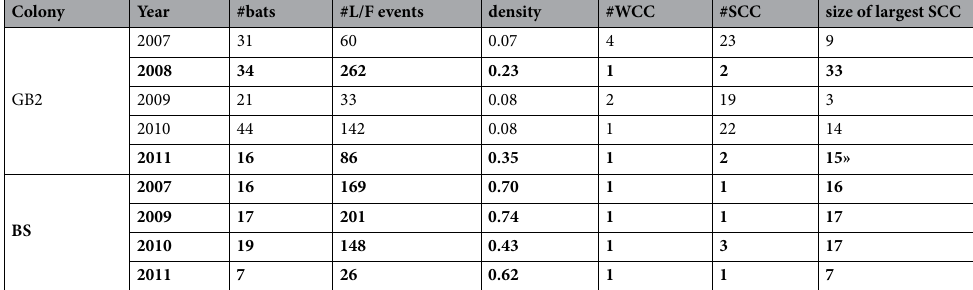
length up to two constitute the majority in all datasets. We, thus, use second-degree centrality with α = 0.5 as the main measure for quantifying individual influence. We will, however, keep in-degree and eigenvector centrality for comparison purposes to make sure that our heuristic metric does indeed reflect a balance between the two extrema and produces consistent results. All analysis was done in the R programming language.